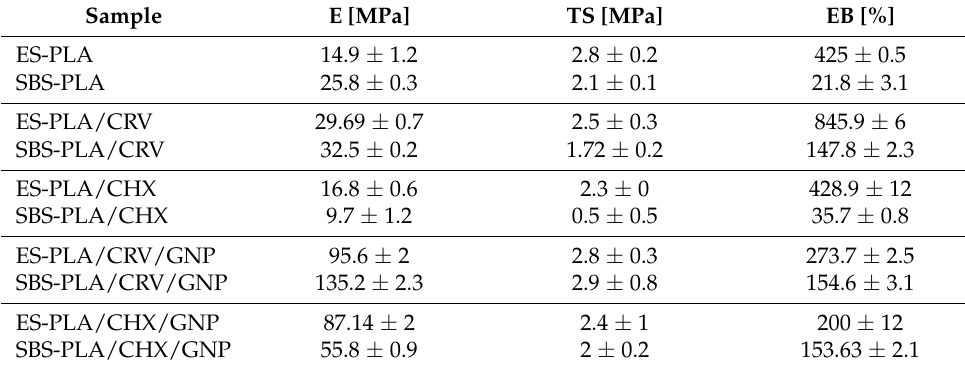
Table 1. Elastic modulus (E), tensile strength (TS), and elongational break (EB) values of PLA, PLA-CRV, PLA-CRV-GNP, PLA-CHX, and PLA-CHX-GNP membranes obtained by ES and SBS processes. Sample E [MPa] TS [MPa] EB [%]